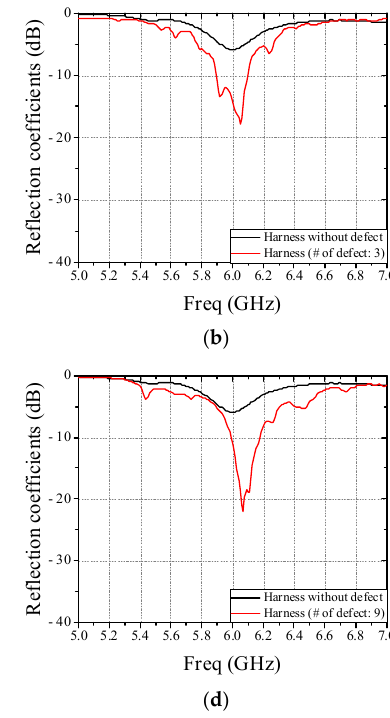
Figure 11. Measured reflection coefficients of patch antenna in cases of real circular harness (9 wires) without and with defect according to the number of defective wire. ( a ) The number of defective wire: 1. ( b ) The number of defective wire: 3. ( c ) The number of defective wire: 6. ( d ) The number of defective wire: 9.